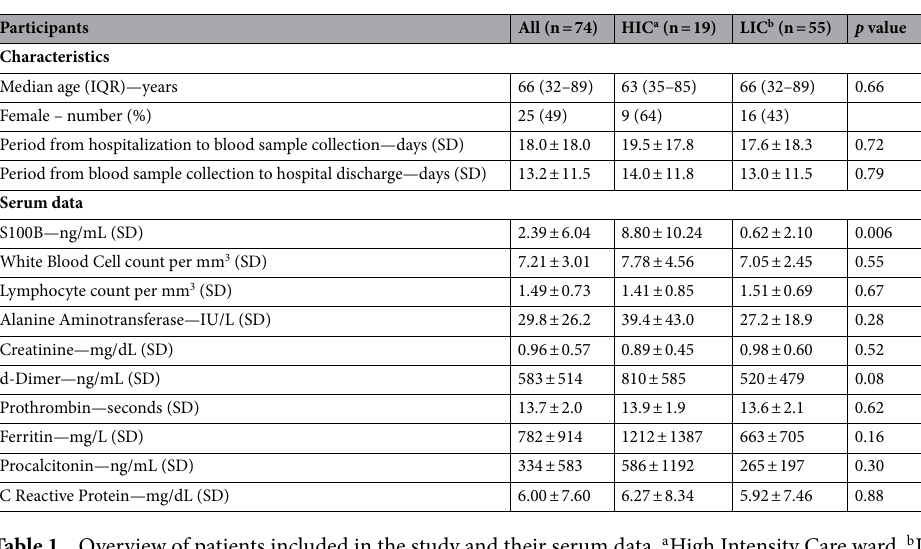
Table 1. Overview of patients included in the study and their serum data. a High Intensity Care ward. b Low Intensity Care